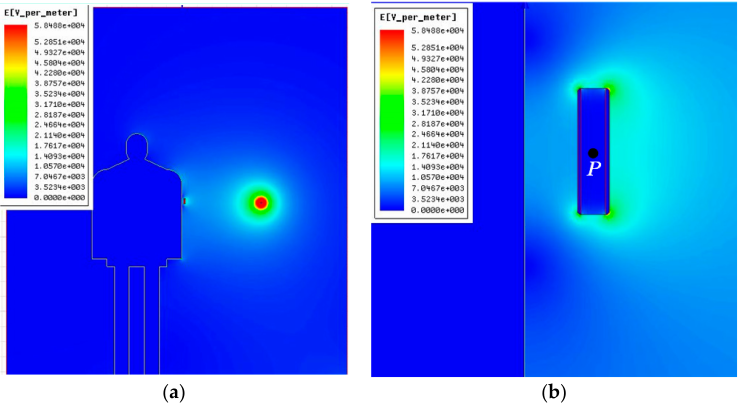
Figure 7. Electric field distribution in the case of an approaching human body. ( a ) Surrounding human body and conductor; ( b ) surrounding measuring sensor. Table 3. Comparison of measured electric field values at point P before and after the approach of a human body (driven by different voltages).